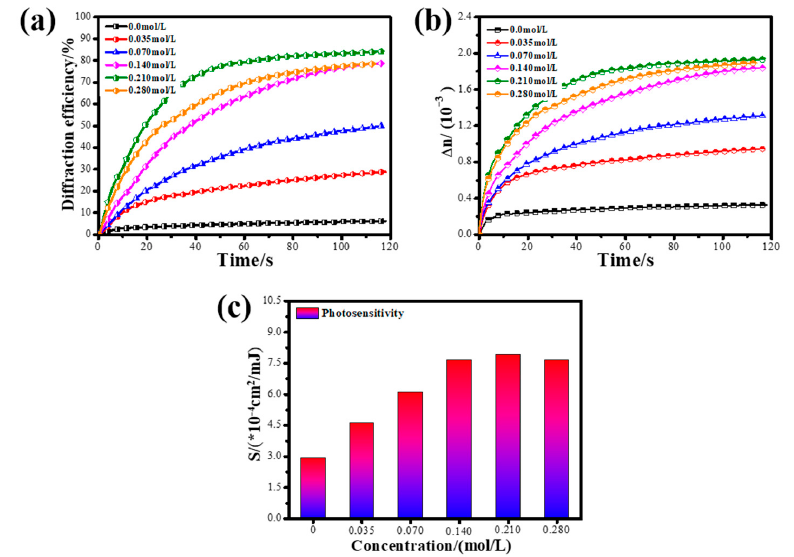
Figure 6. Effect of glycerol on the holographic performance of photopolymers: ( a ) curve of real-time diffraction efficiency; ( b ) curve of refractive index modulation; ( c ) photosensitivity.